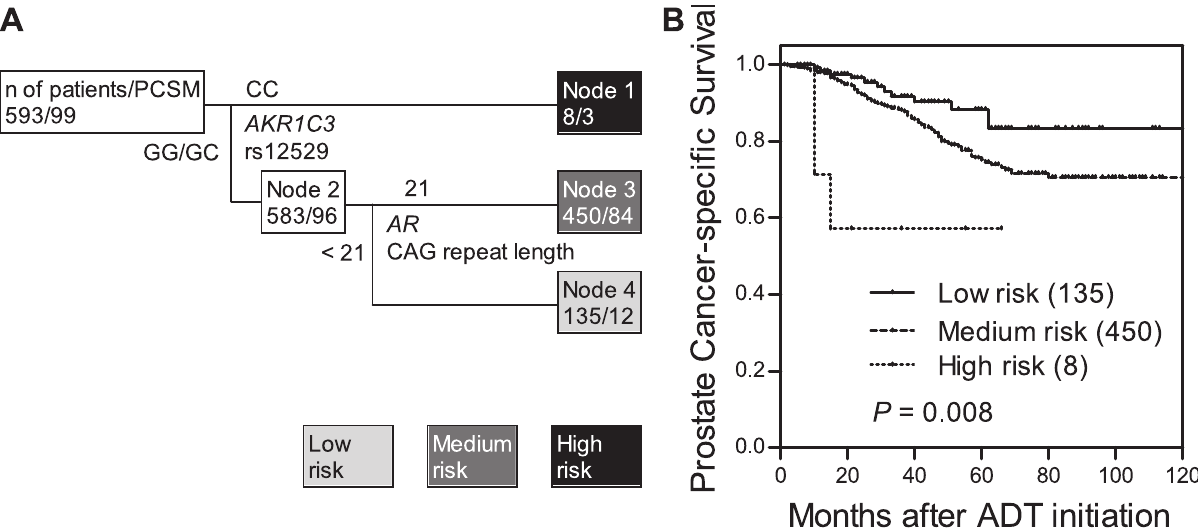
Figure 2. Potential higher order SNP-SNP interactions between AKR1C3 rs12529 and AR -CAG repeat length. (A) Survival tree analysis identifies the interactions between AKR1C3 rs12529 and AR -CAG repeat length. (B) Kaplan-Meier curves of time to PCSM during ADT based on the survival tree analysis. Numbers in parentheses indicate the number of patients.